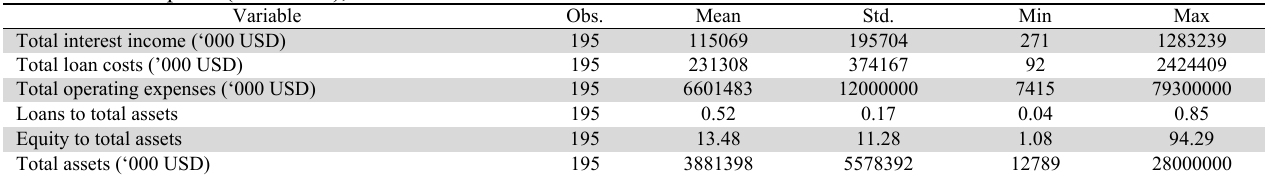
Statistical description (model 3.1), 2005-2012